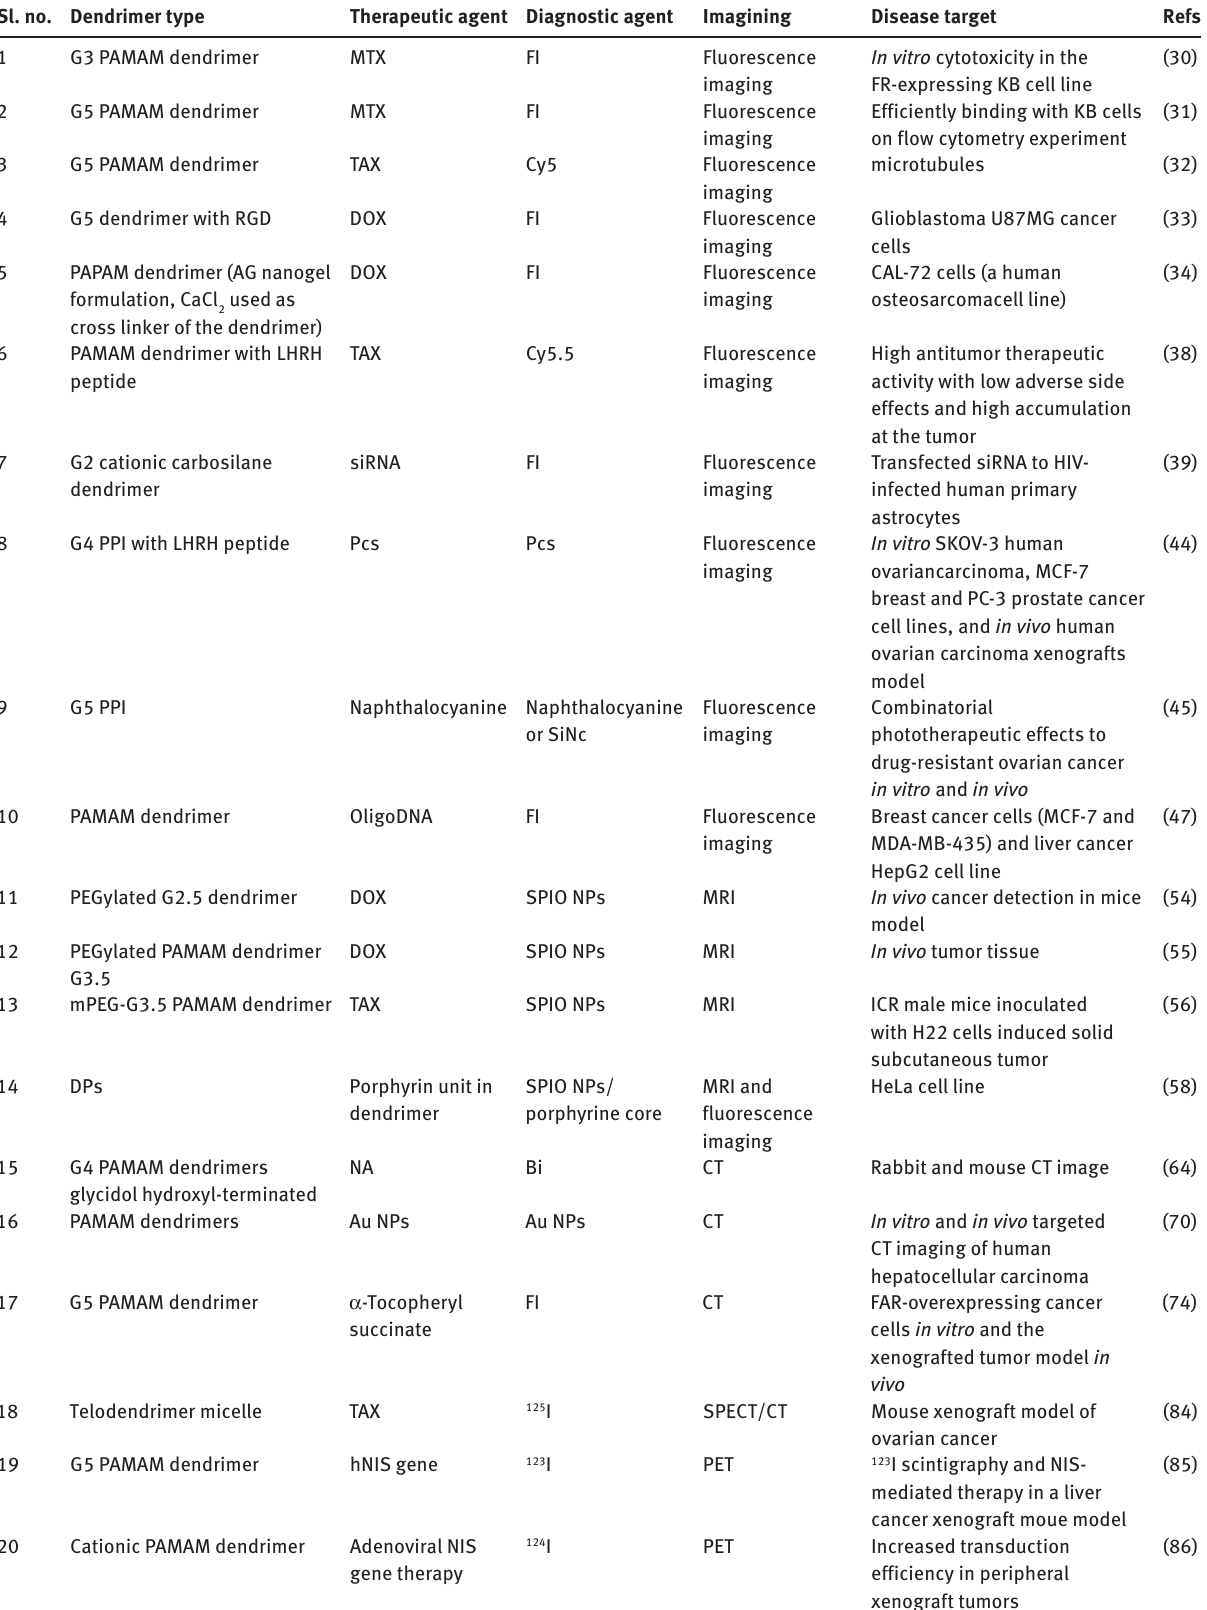
Table 1: Summary of theranostic dendrimers and their application. Sl. no. Dendrimer